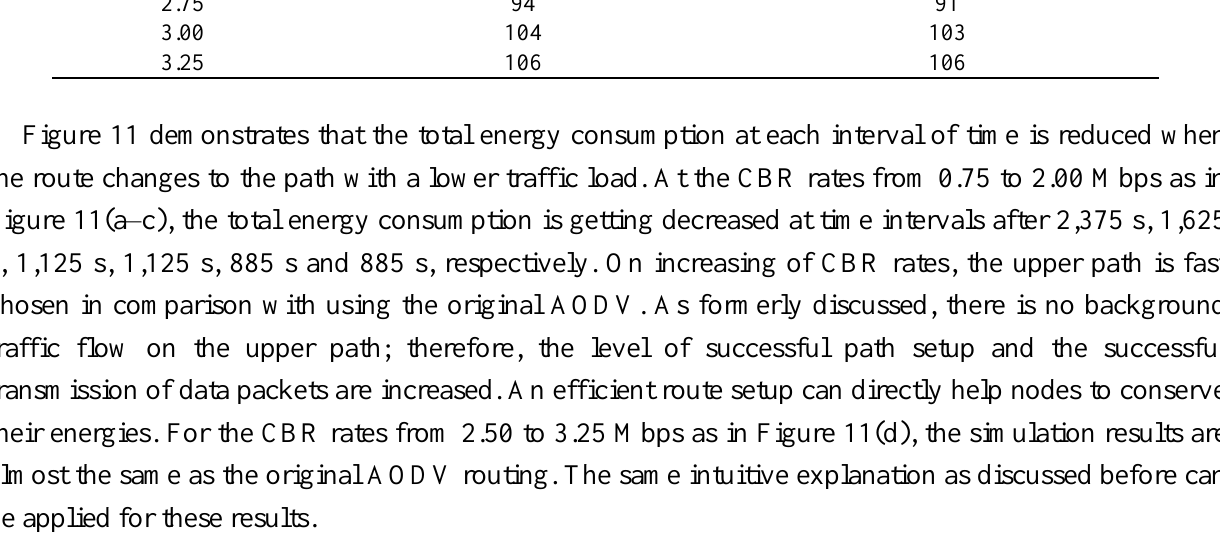
Table 7. Settling time vs . CBR rate (modified AODV).